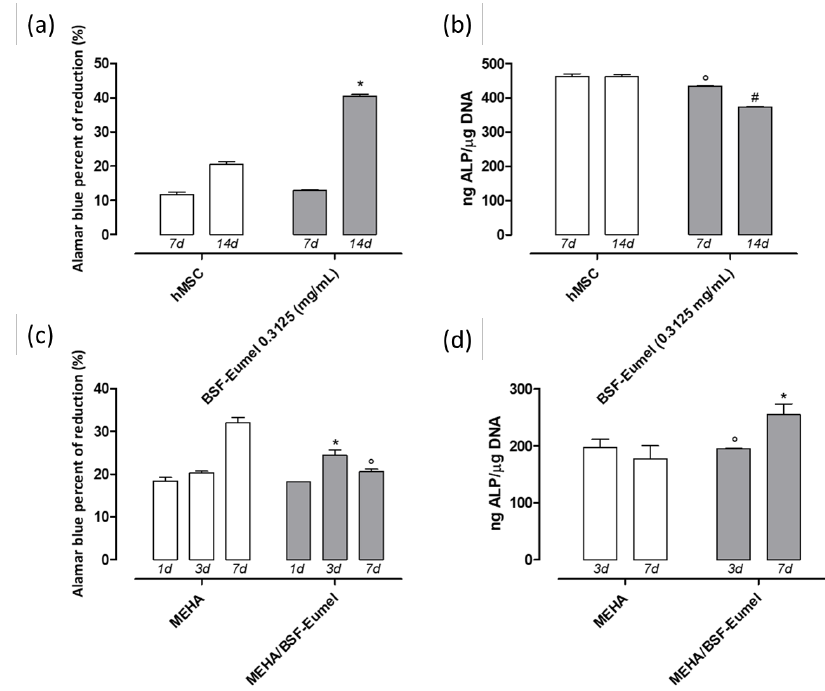
Figure 7. Cell proliferation and differentiation of hMSCs in contact with 0.3125 mg/mL of BSF-Eumel solution at 7 and 14 days of cell culture ( a , b ). Cell proliferation and differentiation of hMSCs seeded on MEHA- and MEHA/BSF-Eumel-based scaffolds after 1, 3 and 7 days of cell culture ( c , d ). * p < 0.05; ° p < 0.001; # p < 0.0001 vs control group.